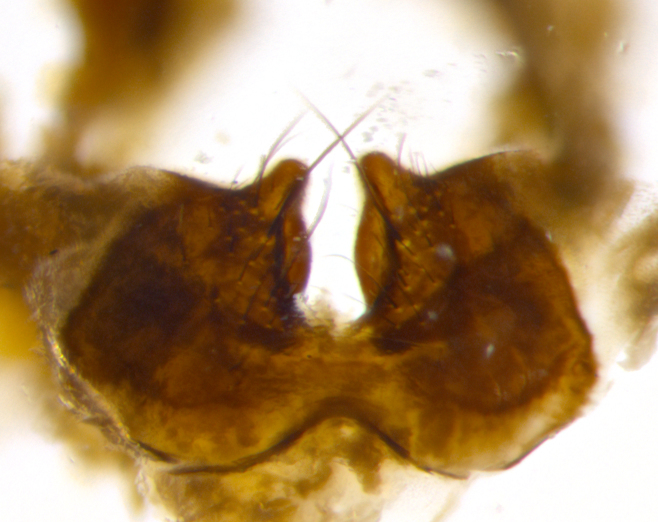
sternite 5, ventral view